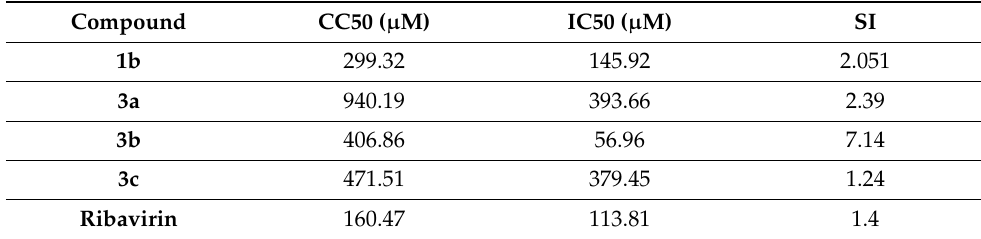
Table 5. 229E inhibitory activity in biochemical assay of compound 1d , 3a , 3b , and 3c . Data are mean ± standard deviation of three individual experiments.